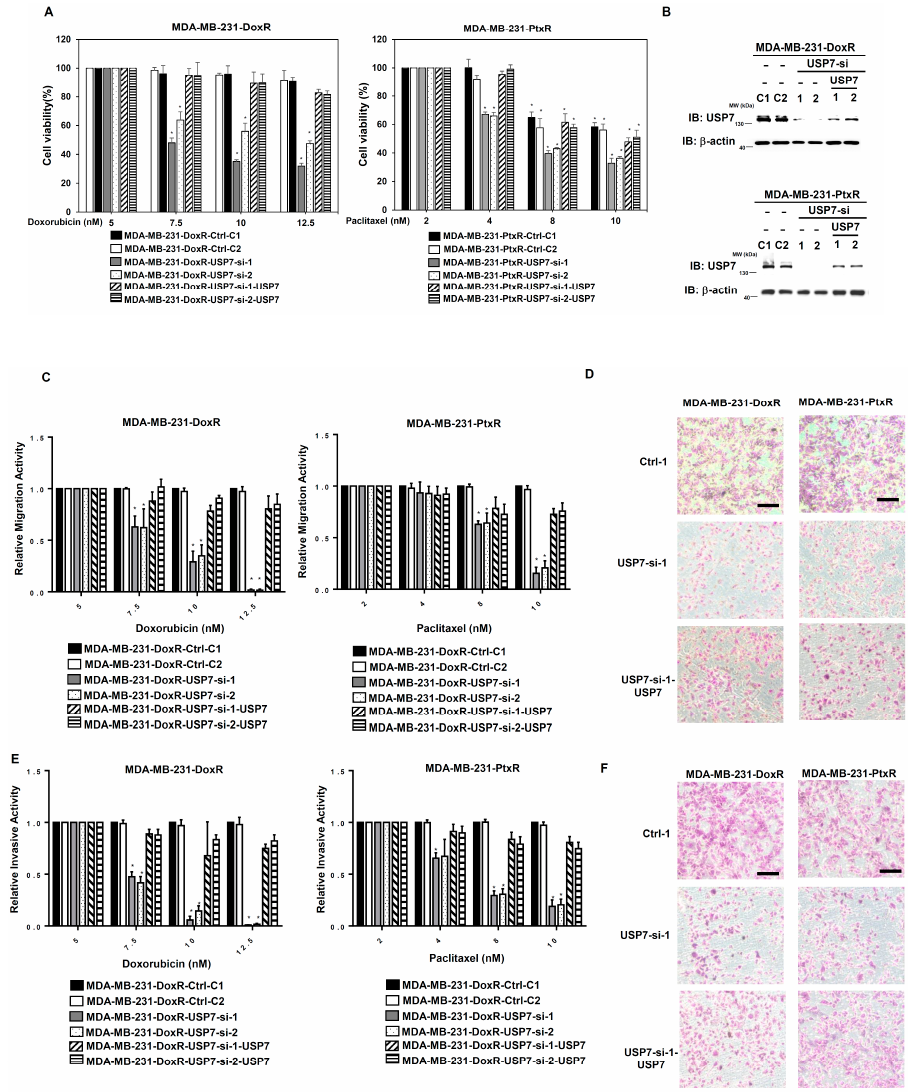
Figure 5. Effect of re-expression of USP7 in chemoresistant triple-negative breast cancer-USP7- silencing cells on cell viability and metastasis. ( A ) Analysis of the viability of MDA-MB-231-DoxR- USP7-silencing (left) and MDA-MB-231-PtxR-USP7-silencing (right) cells with empty vector/USP7 expression treated with serial doses of doxorubicin or paclitaxel, using MTT assays. ( B ) USP7 expres- sions in MDA-MB-231-DoxR-USP7-silencing (upper) and MDA-MB-231-PtxR-USP7-silencing (lower) cells with empty vector/USP7 expression, by western blot analysis with specific antibodies. ( C ) Rela- tive migration activity of MDA-MB-231-DoxR-USP7-silencing (left) and MDA-MB-231-PtxR-USP7- silencing (right) cells with empty vector/USP7 expression treated with serial doses of doxorubicin and paclitaxel, respectively, using in vitro Transwell-dependent migration assays. ( D ) Images for mi- gration activity of MDA-MB-231-DoxR-USP7-silencing (left) and MDA-MB-231-PtxR-USP7-silencing (right) cells with empty vector/USP7 expression treated with 10 nM of doxorubicin and 8 nM of paclitaxel, respectively. ( E ) Relative invasive activity of MDA-MB-231-DoxR-USP7-silencing (left) and MDA-MB-231-PtxR-USP7-silencing (right) cells with empty vector/USP7 expression treated with serial doses of doxorubicin or paclitaxel, respectively, using in vitro Transwell-dependent in- vasion assays. ( F ) Images for the invasive activity of MDA-MB-231-DoxR-USP7-silencing (left) and MDA-MB-231-PtxR-USP7-silencing (right) cells with empty vector/USP7 expression treated with 10 nM of doxorubicin or 8 nM of paclitaxel, respectively. Data are represented as the mean ± SEM for biological triplicate experiments. * p < 0.05, compared with cells with steady concentration of doxorubicin and paclitaxel,